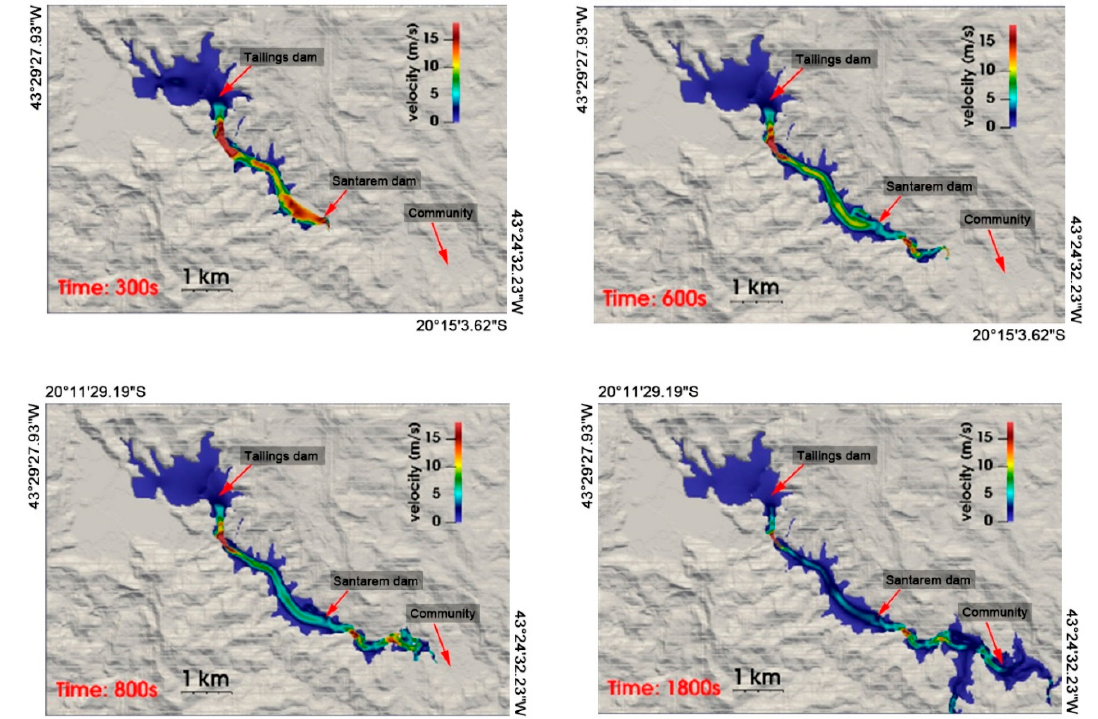
Figure 8. SPH numerical results of the Samarco tailings dam failure accident.